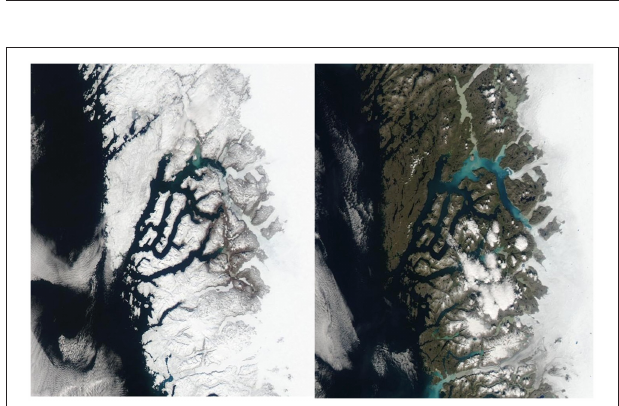
FIGURE 2 | MODIS images of the Godthåbsfjord region (west Greenland) close to our May and August cruise dates. AQUA 11/05/2014 (left) and 06/08/2014 (right) . Images provided by the Danish Meteorological Institute 1